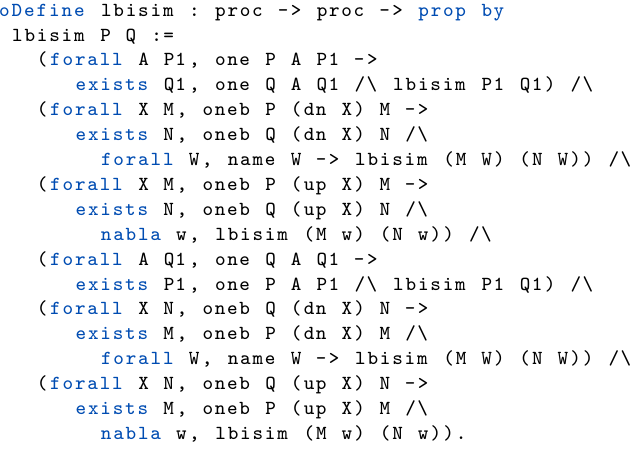
Fig. 4: The specification of late